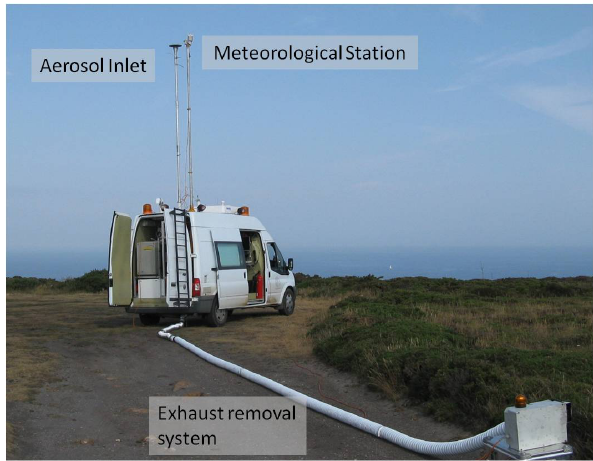
Fig. 7. Stationary measurements in downtown Mainz, Germany (grey shaded) and at a background site upwind of the city (green shaded) during a student’s exercise in April 2011. Elevated con- centrations and multiple short peaks of traffic-related pollutants are observed during the city-measurement (left panel). For most param- eters average concentrations at the background site are significantly lower (right panels). NC: particle number concentration; BC: partic- ulate black carbon, Org: particulate organics, SO 4 : particulate sul-